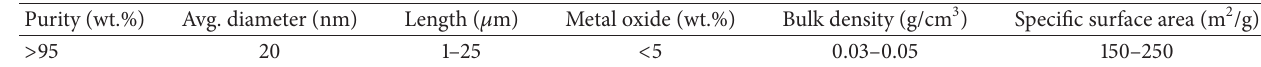
Figure 2: (a) SEM and (b) TEM images of pristine MWCNTs. Table 2: Properties of